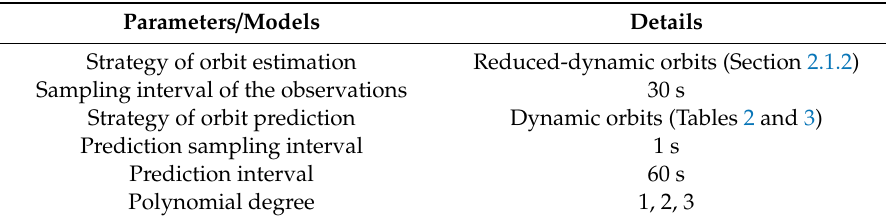
Table 5. Details of the Level B orbital products.